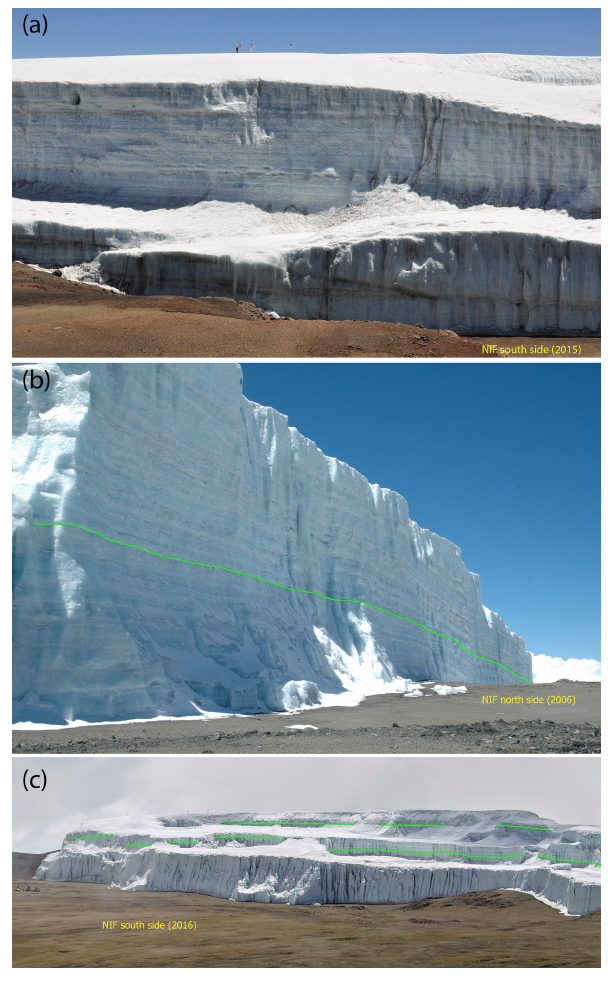
Figure 8. Multiple views of the stratigraphy at NIF’s vertical walls. The top row (a) shows the ice front near the vertical wall sampling site with a person standing next to the AWS. Note the exceptional inclined dark layer merging with another horizontal layer close to the crater surface. The ice front reveals distinct layers that are pre- dominantly horizontal, seen both on the north and south side ( b and c , respectively). Examples of the distinct layers are highlighted as green lines.